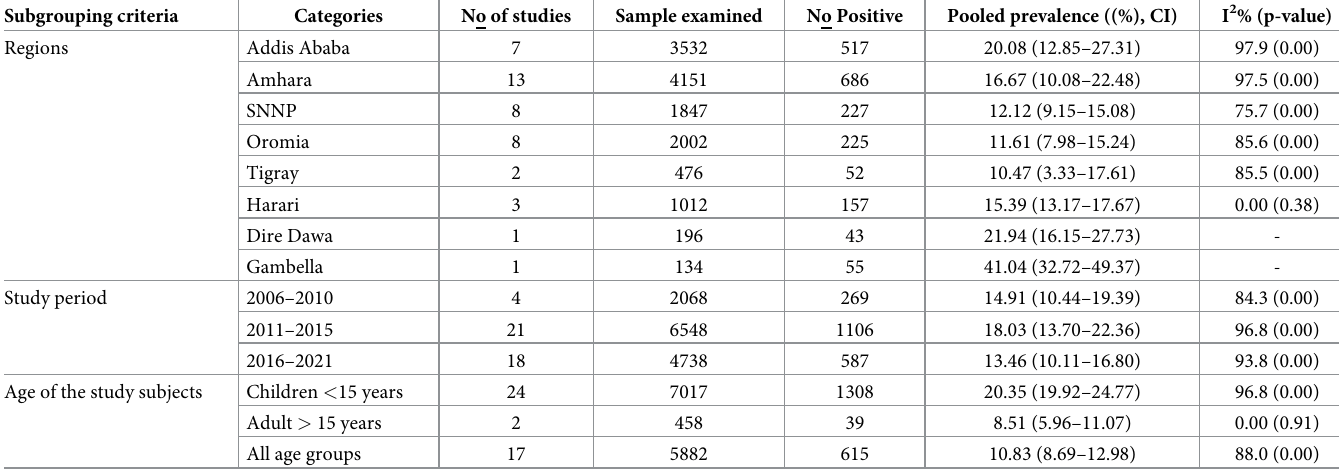
Table 2. The pooled prevalence of Gram-negative enterobacterial pathogens from diarrheic patients based on different subgrouping criteria. Subgrouping